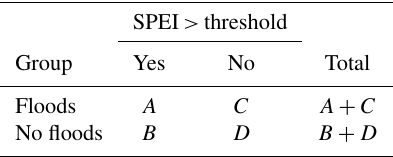
Table 2. Parameters for RR